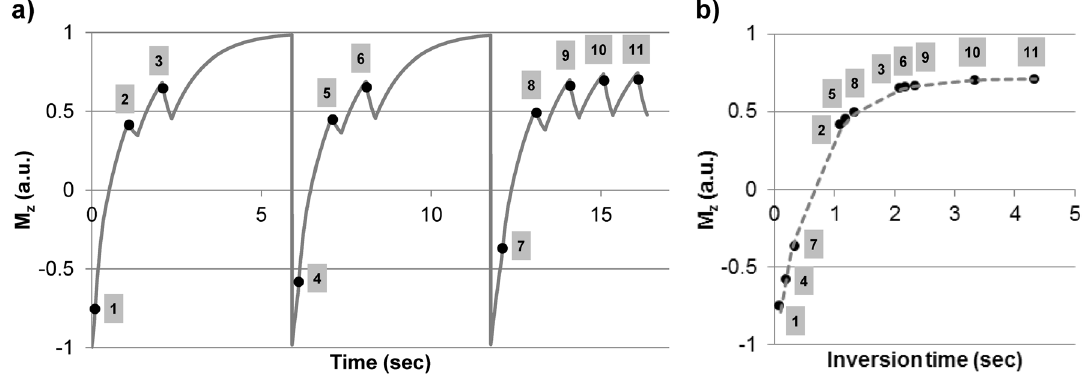
Figure 1. MOLLI acquisition and data fitting: a) Simulated longitudinal magnetization during MOLLI acquisition (T 1 =1000 ms, T 2 =30 ms, readout flip angle=30 6 , echo train length=64, heart rate=60 bpm). Note the complex pattern of the underlying magnetization evolution due to mixed periods of bSSFP readout and free relaxation. MOLLI data are sampled at 11 inversion times marked; b) Conventional MOLLI fitting approximates the rearranged MOLLI data with a mono-exponential function to derive an apparent T 1 , which is then corrected according to Eq.1.